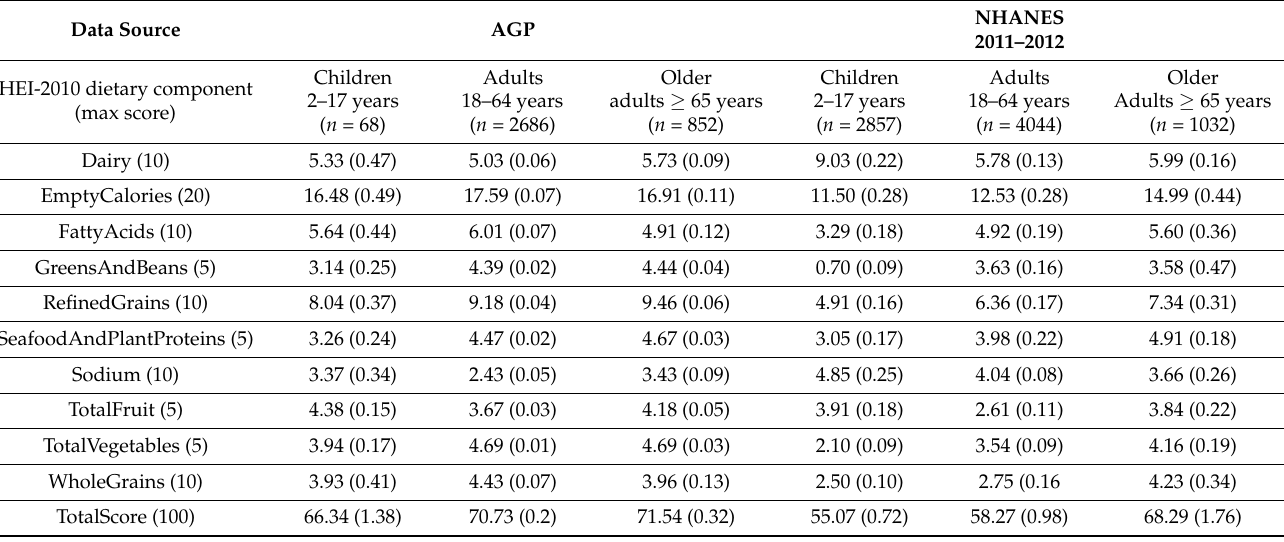
Table 1. Comparison * of diet quality measured as healthy eating index between AGP subjects and general American population (NHANES